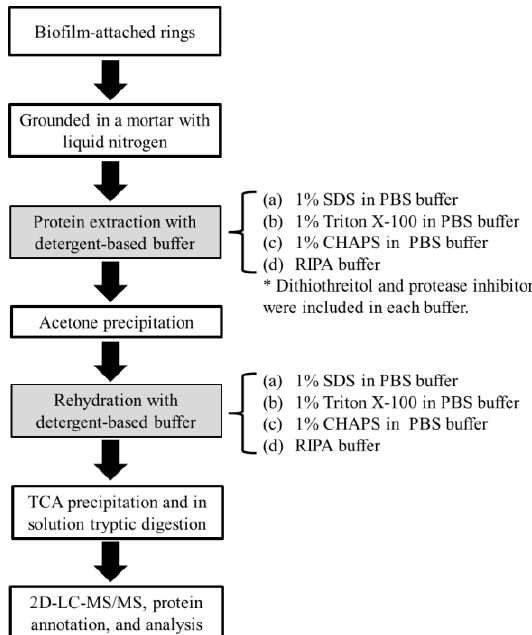
Figure 1. Schematic workflow for protein extraction from biofilms with detergent-containing buffers. SDS (sodium dodecyl sulfate), PBS (phosphate buffered saline), CHAPS (3-[(3-cholamidopropyl)dimethylammonio]-1-propanesulfonate), RIPA (radioimmunoprecipitation assay buffer), TCA (trichloroacetic acid) and 2D-LC-MS/MS (two-dimensional liquid chromatography tandem mass